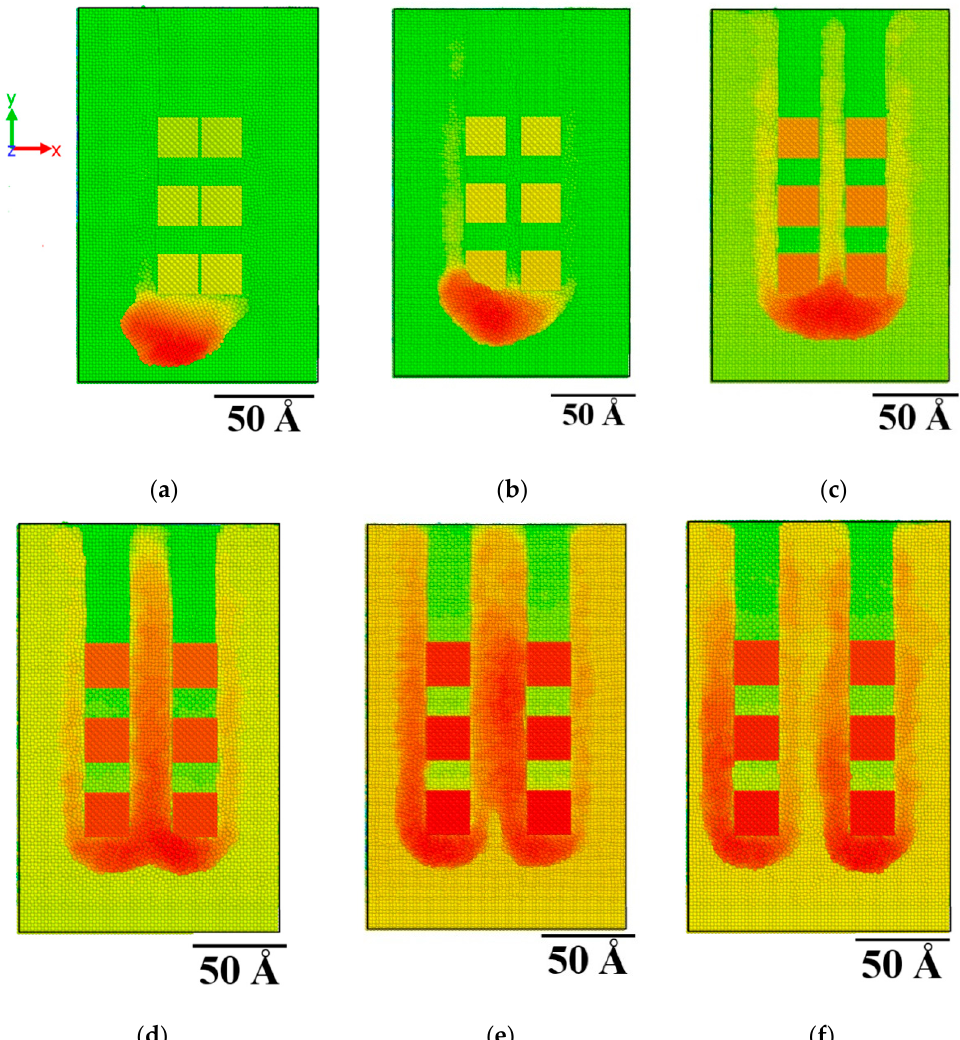
Figure 3. Top view of the workpiece at the final timestep for the cases with a spacing of: ( a ) 1a, ( b ) 3a, ( c ) 5a, ( d ) 7a, ( e ) 9a, and ( f ) 11a.